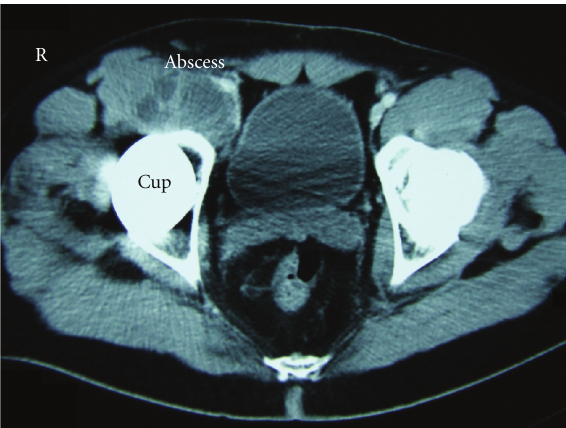
Figure 2: S. lugdunensis whole cell matrix-assisted laser desorp- tion/ionisation time-of-flight MS fingerprint. Bacteria were covered with a layer of matrix ( α -Cyano-4-hydroxy-cinnamic acid) and submitted for analysis. The proteomic fingerprint in the mass-to- charge ratio (Da) from 3000 Da to 15.000 Da was species specific and was matched to the Biotyper 2.0 database (Bruker Daltonics). Within a few minutes a highly accurate identification up to the species level was